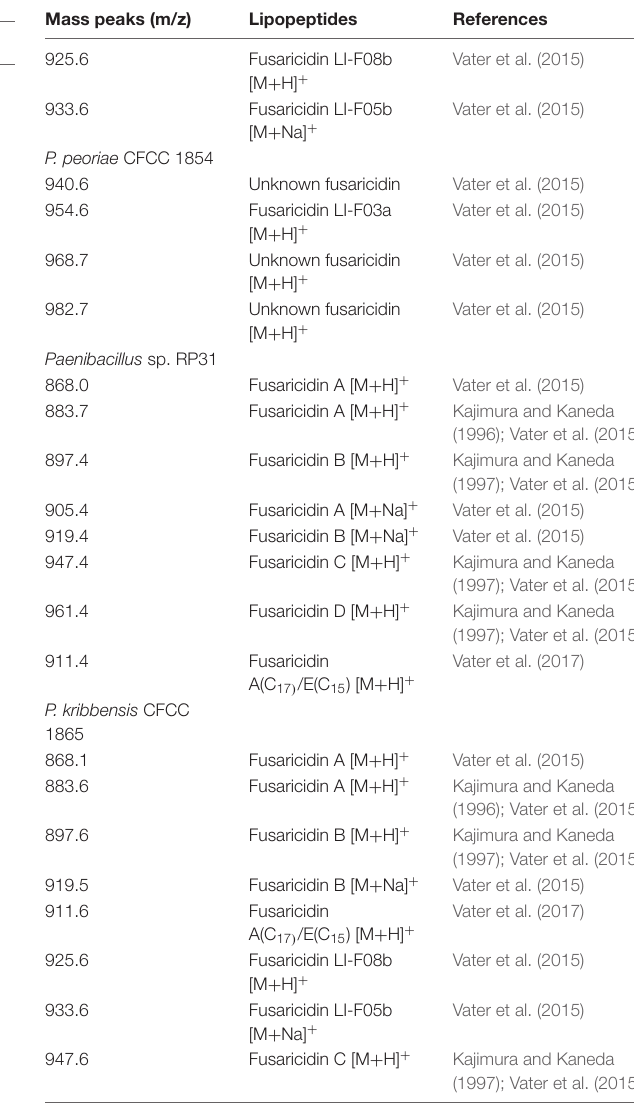
Kajimura and Kaneda (1997); Vater et al. (2015)